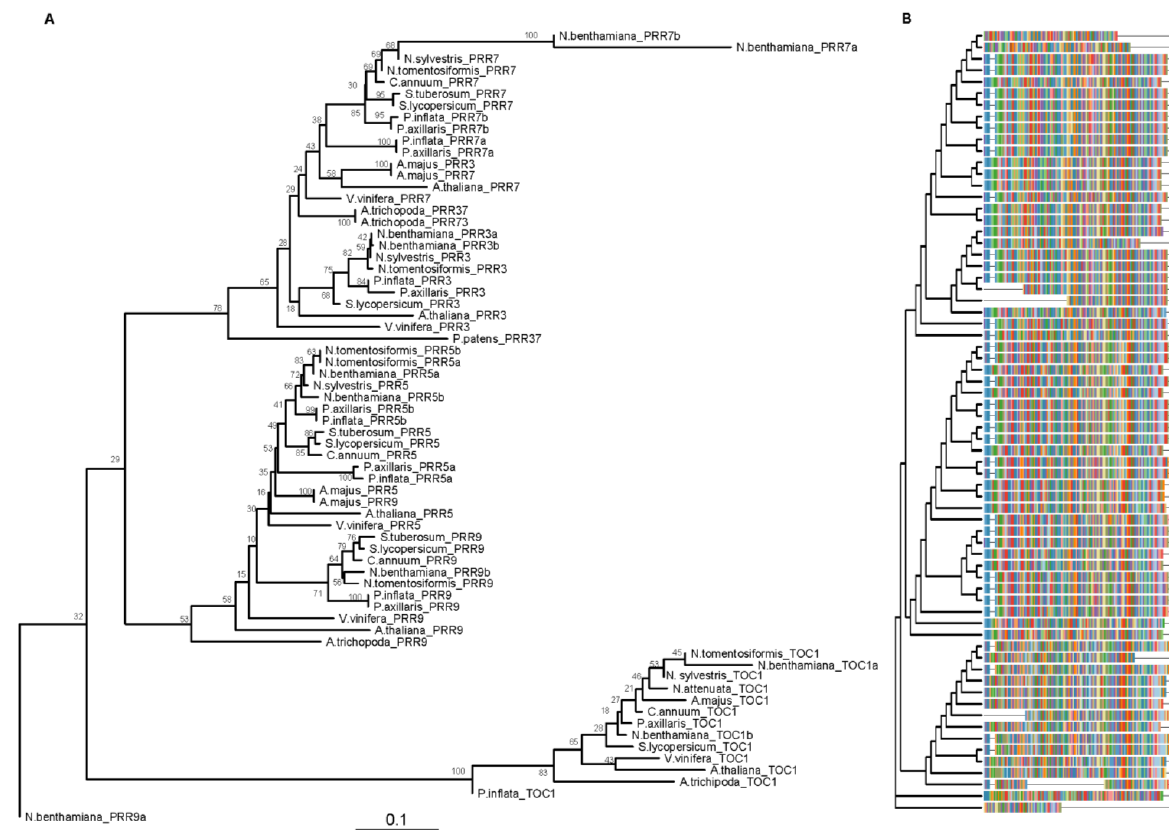
Figure 1. PSEUDO-RESPONSE REGULATORS (PRRs) phylogenetic tree. Pseudo-receiver (PR) amino acid sequences were aligned using CLUSTALX. Phylogenetic analysis was performed using MEGA X and trees were plotted with the library “ggtree” (R version 3.5.1). The phylogenetic tree was estimated using the neighbor-joining algorithm (NJ) JTT (Jones, Taylor and Thornton) as model of amino acid substitution. The tree shows the bootstrap percentage (from 500 replicates) next to branches. The tree was plotted to scale ( A ). The multiple sequence alignment is showed on the right side ( B ). This tree contains 69 sequences from 14 species. Species abbreviations: A.majus ( Antirrhinum majus ), A.thaliana ( Arabidopsis thaliana ), A.trichopoda ( Amborella trichopoda ), C.annuum ( Capsicum annuum ), N.attenuata ( Nicotiana attenuata ), N.benthamiana ( Nicotiana benthamiana), N.sylvestris ( Nicotiana sylvestris ), N.tomentosiformis ( Nicotiana tomentosiformis ), P.axillaris ( Petunia axillaris ), P.inflata ( Petunia inflata ), P.patens ( Physcomitrella patens ), S.lycopersicum ( Solanum lycopersicum ), S.tuberosum ( Solanum tuberosum) and V.vinifera ( Vitis vinifera ). Accessions are listed in Table